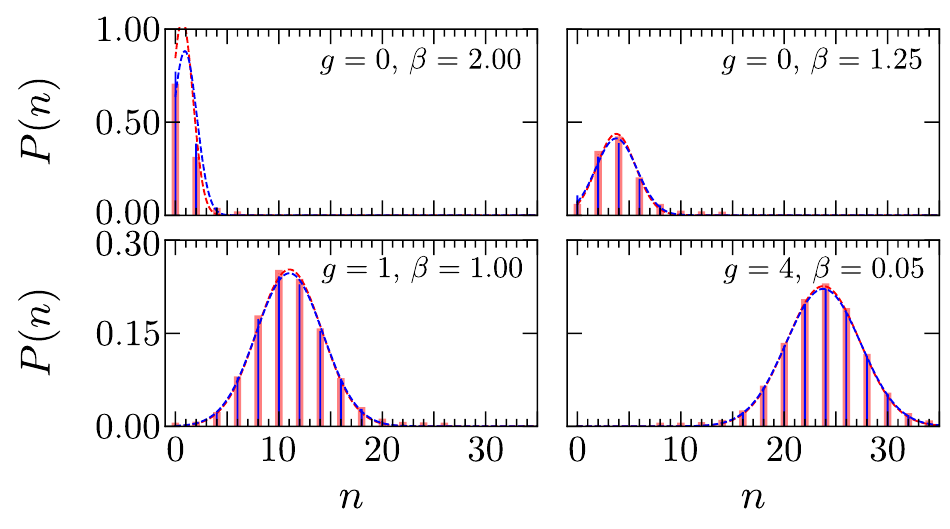
Figure 4: Exact and Coarse-grained PPA kink-number probability distributions at thermal equilibrium. The exact kink-number probability distribution evaluated using Eq. (85) (red) is compared with the coarse-grained PPA probability distribu- tion Eq. (92) (blue). The numerical histograms are compared with the Gaussian ) with fitted numerical values for κ N ( κ , κ and κ (dashed lines). In as much as 1 2 1 2 the exact distribution is symmetric and its left tail is negligible near the origin, the coarse-graining of the PPA distribution in Eq. (92) reproduces accurately the exact distribution. Deviations are manifested at low g and temperature, when the distri- bution is